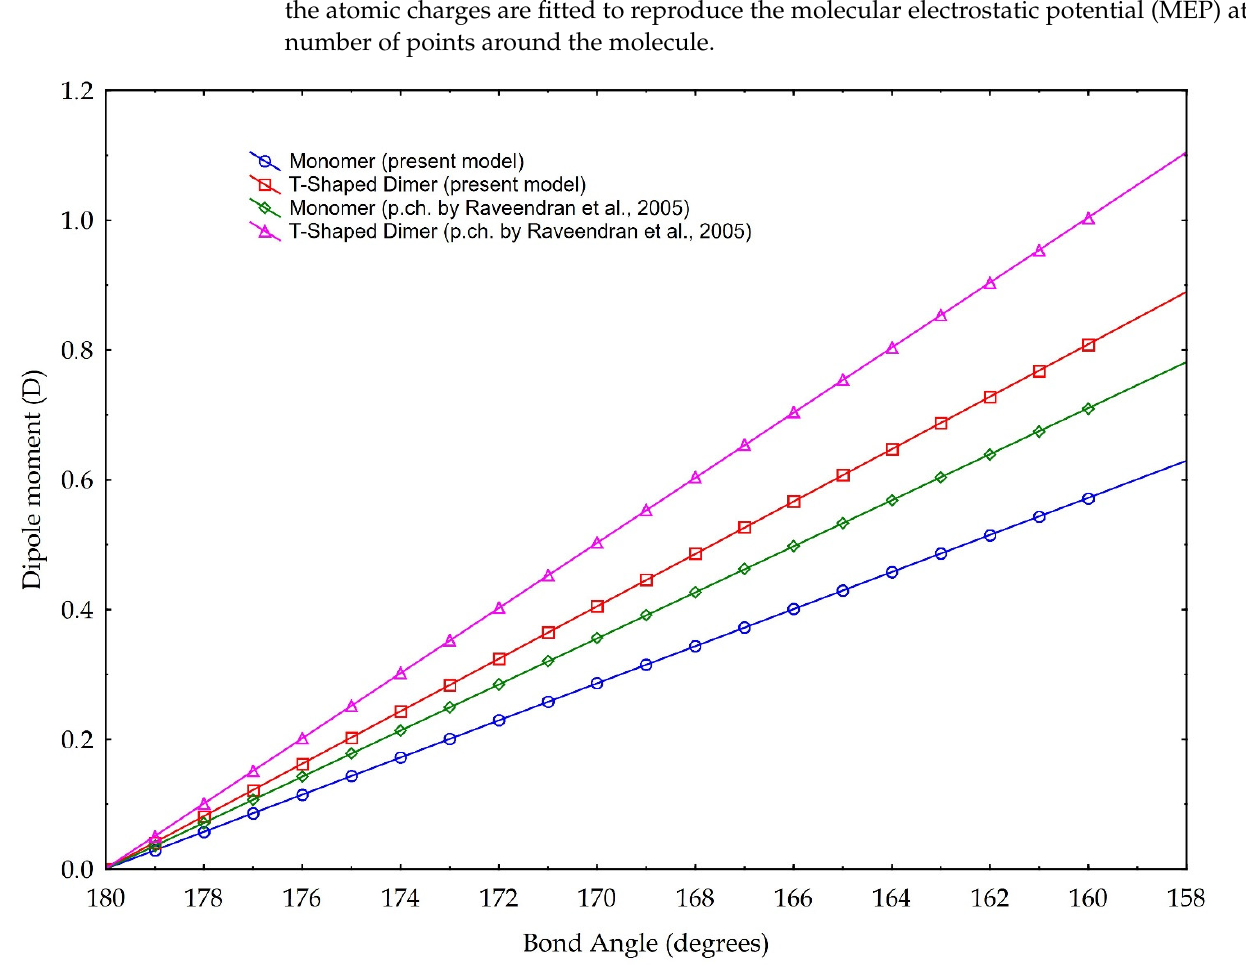
Figure 8. Dipole moment versus molecule CO 2 bond angle. Blue and red graphics are based on the partial charge values calculated in our model, according to Pauling electronegativity. Green and purple graphics are the values calculated according to the partial charge calculated in [3]. Two cases are presented: blue and green are values referring to monomer, red and purple refer to a T-shaped dimer (see text for explanation).